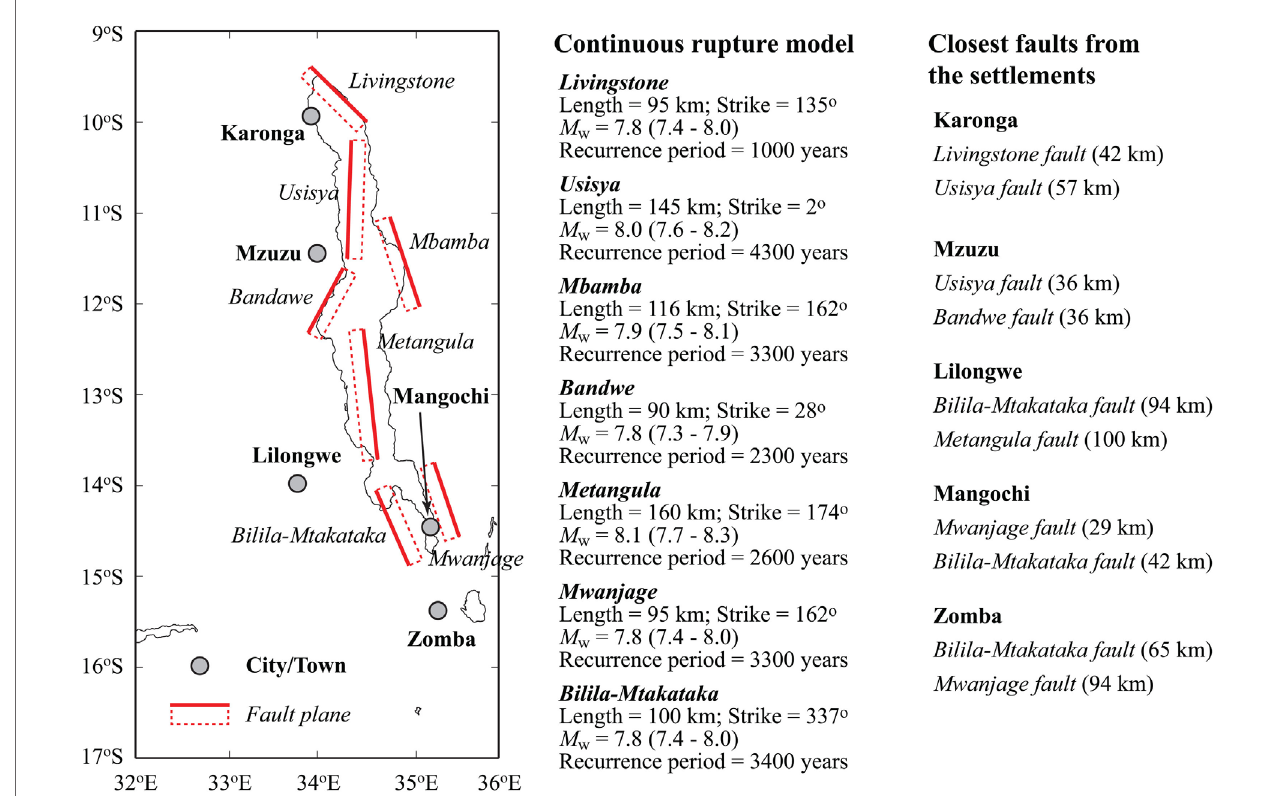
FigUre 4 | Fault maps of the continuous rupture model for Malawi [modified from hodge et al. (2015)]